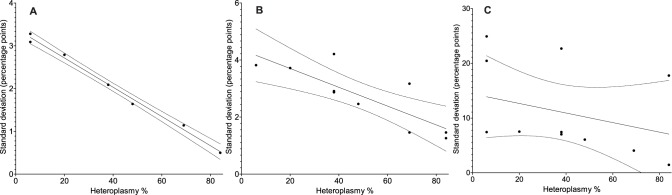
Relationship between MT-ND1/MT-ND4 deletion assay variability and heteroplasmy level at high, moderate and low DNA concentrations.For all panels, percentage point standard deviations of DNA sample replicates (n = 84) are displayed relative to deletion heteroplasmy in homogenate skeletal muscle samples. Regression lines (solid) and 95% confidence intervals for the regression lines (dotted lines) are shown. A Linear relationship (n = 7, r = −0.997, P<0.0001) between the percentage MT-ND4 deletion level (heteroplasmy) and MT-ND1/MT-ND4 deletion assay variation at high DNA concentrations (average Cq values for all DNA samples below 25). B A similar linear relationship (n = 10, r = −0.831, P = 0.0029) is seen at moderate DNA concentrations (average Cq values for all DNA samples between 25 and 30). C At low DNA concentrations (average Cq values for all DNA samples above 30) there is not a significant linear trend (n = 11, r = −0.209, P = 0.5368).